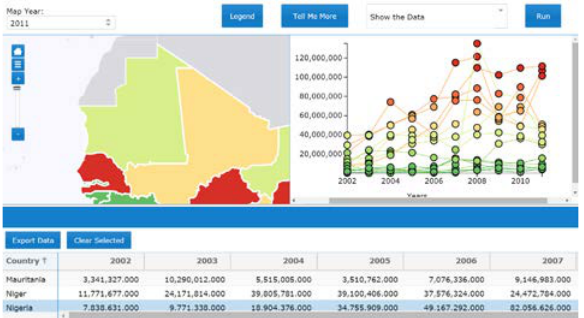
Figure 6. WSTAMP online analytical environment.